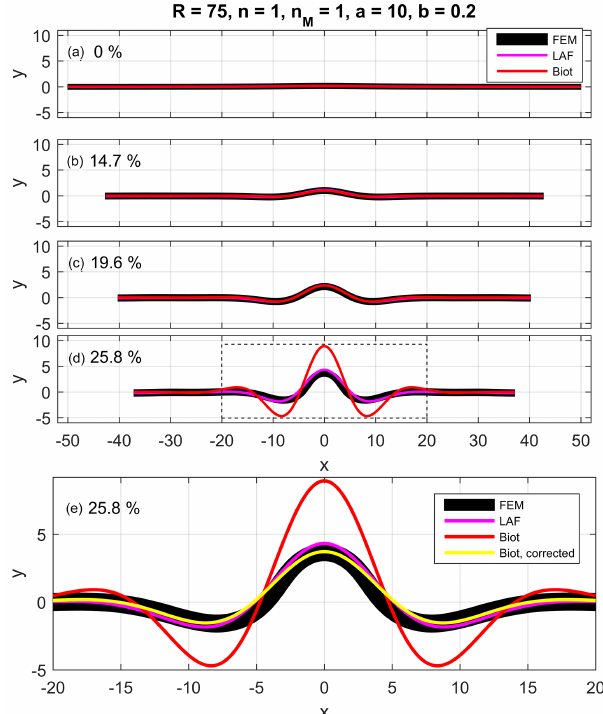
Figure 16. Evolution of fold geometry for an initial geometrical bell-shaped perturbation calculated with the analytical solution of Biot et al. (1961; Eq. 27; red line), the LAF solution of Adamuszek et al. (2013; magenta line) and a numerical finite element simula- tion (black layer). The parameters for the bell-shaped perturbation are a = 10 and b = 0.2 (initial layer thickness is 1), and the linear viscosity ratio is 75. Numbers in panels in % represent bulk short- ening. (e) shows an enlargement of (d) (enlarged region is indicated by dashed rectangle). In (e) the yellow line corresponds to the case where arc-length shortening rather than bulk shortening is used in the solution of Biot et al. (1961; Eq. 27), as discussed in the text. At lower values of shortening (a, b, c) this result does not differ significantly from that for the uncorrected Biot or